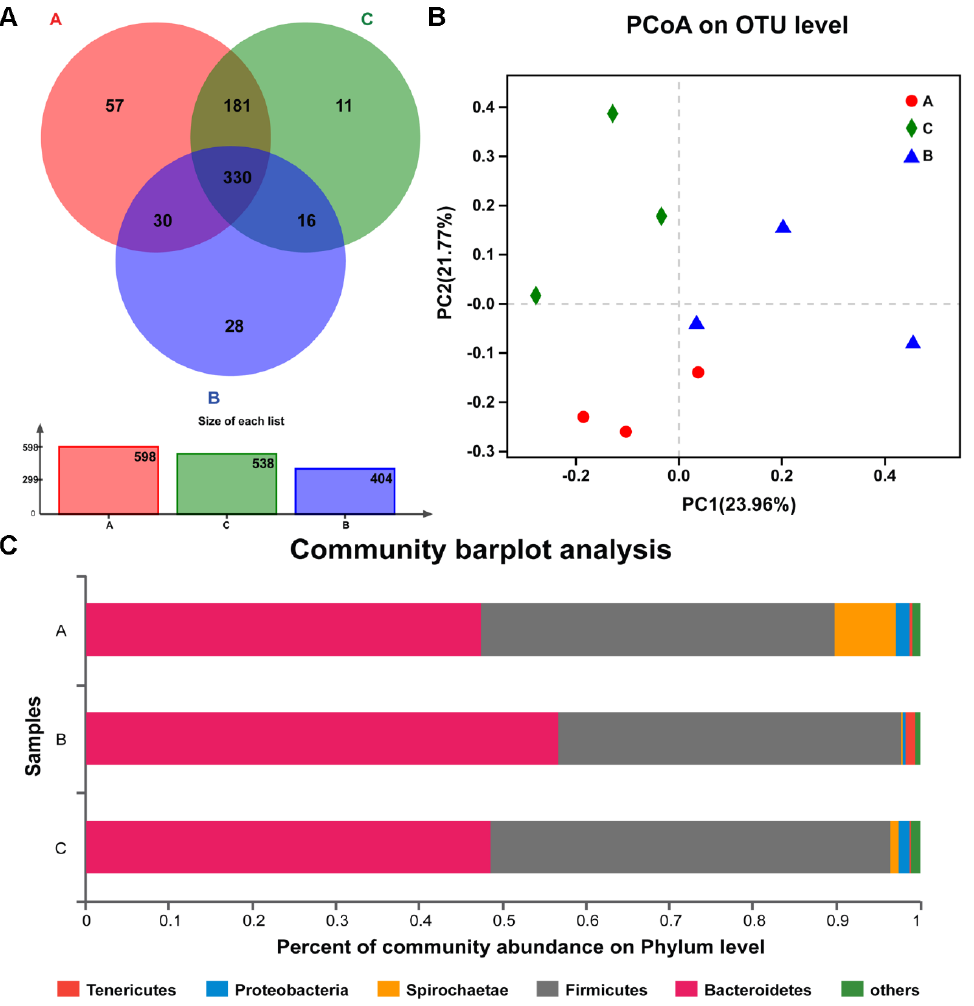
Figure 2. Venn and Principal Coordinates Analysis (PCoA) analyses for bacterial composition in piglet feces. ( A ) Venn diagrams for bacterial OTUs in groups A, B and C. ( B ) Principal coordinate analysis based on unweighted UniFrac metrics in groups A, B and C. ( C ) Fecal bacterial composition calculated at the phylum level. The di ff erent colors represent the relative abundance of bacteria in three groups. Group A: basal diet; group B: basal diet supplemented with antibiotics and zinc oxide; group C: basal diet supplemented with 0.06%